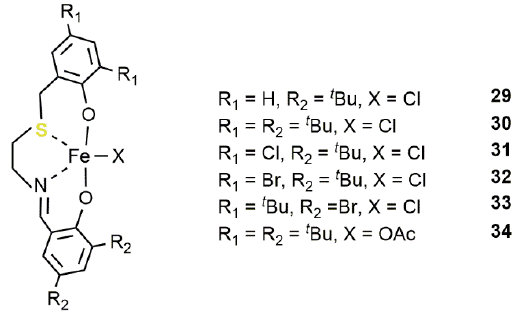
Figure 19. ([ONSO]-type) Fe(III) complexes 29–34 [72].